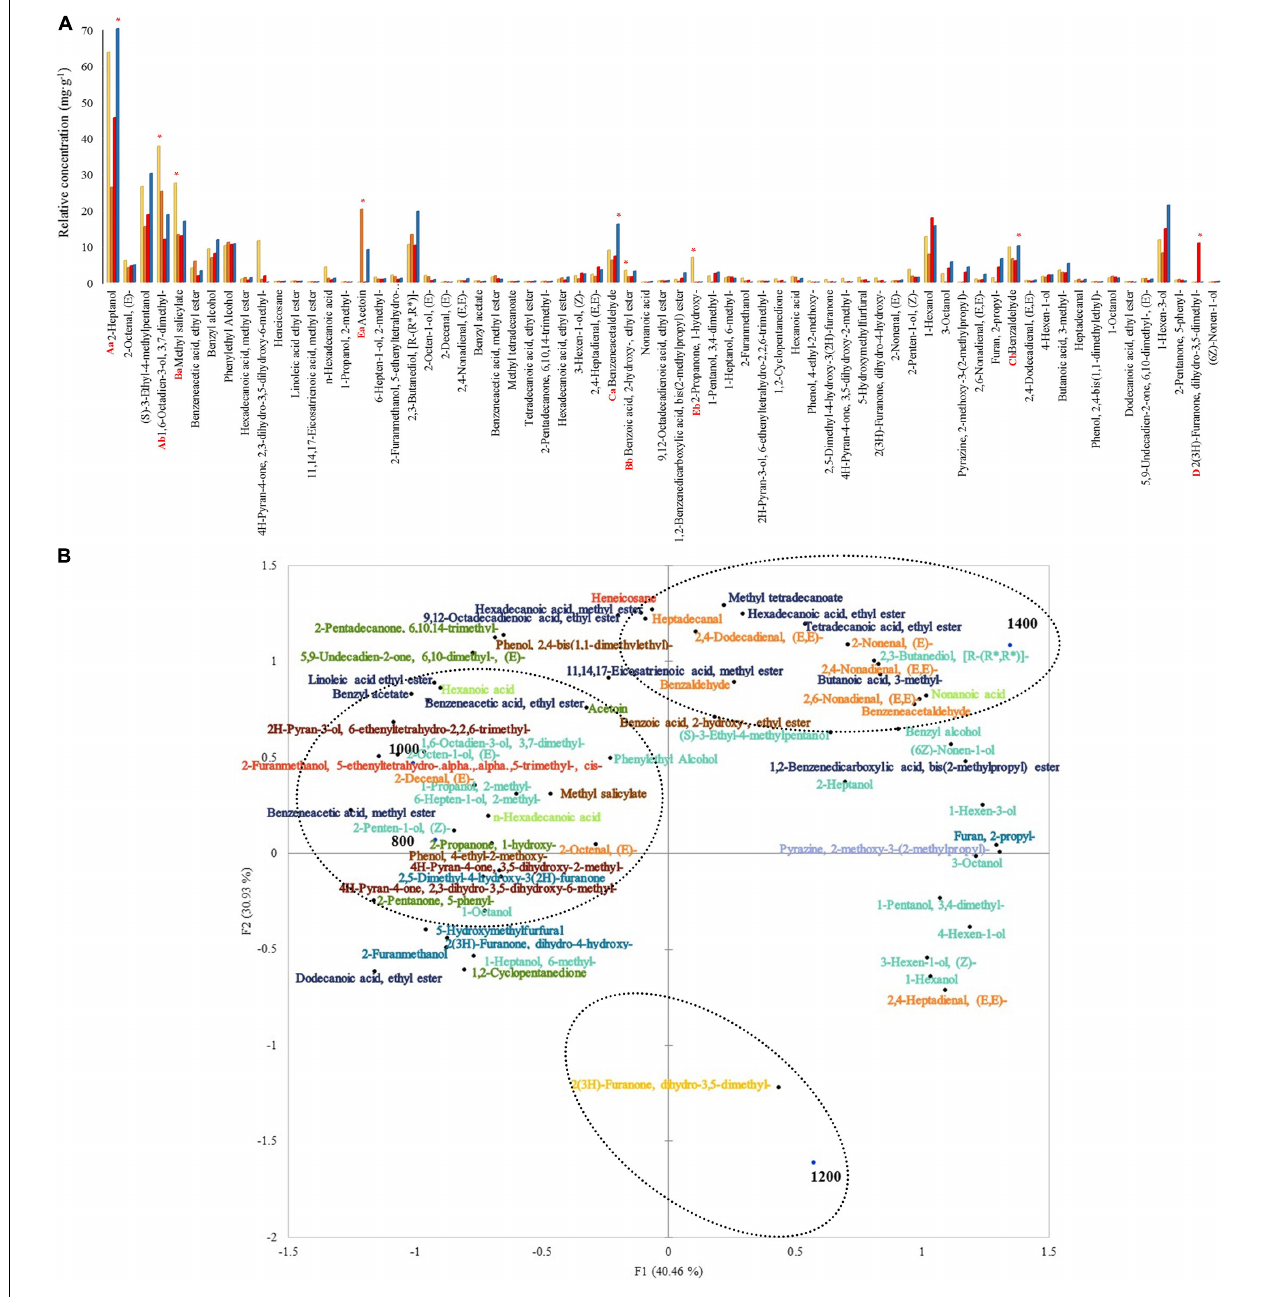
FIGURE 5 | (A) Volatile compounds relative concentrations at 48 h of fermentation on different altitudes. Each bar represents an altitude: (cid:4) 800, (cid:4) 1,000, (cid:4) 1,200, and (cid:4) 1,400 m. Significant values ( p ≤ 0.05) are represented in letters. From the highest amount to lowest, different uppercase letters represent the most predominant groups (A: alcohols, B: phenols, C: aldehydes, D: lactones, and E: ketones), and different lowercase letters represent the two most predominant compounds within the groups. * Altitude that was statistically significant ( p ≤ 0.05) and higher in contrast to the other altitudes. (B) Principal component analysis (PCA) plot of volatile compounds and altitudes. Volatile groups: (cid:4) acids, (cid:4) alcohols, (cid:4) aldehydes, (cid:4) alkanes, (cid:4) esters, (cid:4) furans, (cid:4) ketones, (cid:4) lactones, (cid:4) phenols, (cid:4) pyrans, (cid:4) pyrazines.